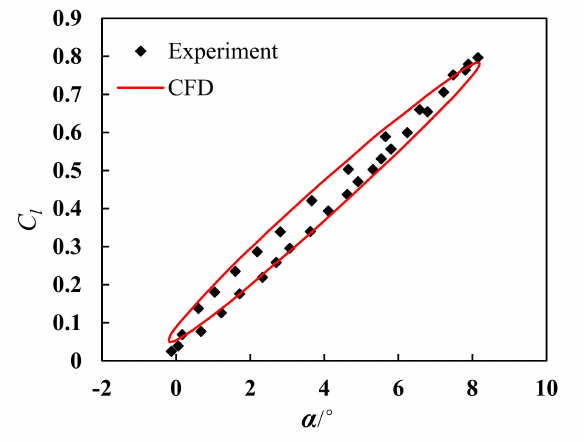
Figure 4. Lift coe ffi cient of the NACA0015 airfoil with pitching oscillation.